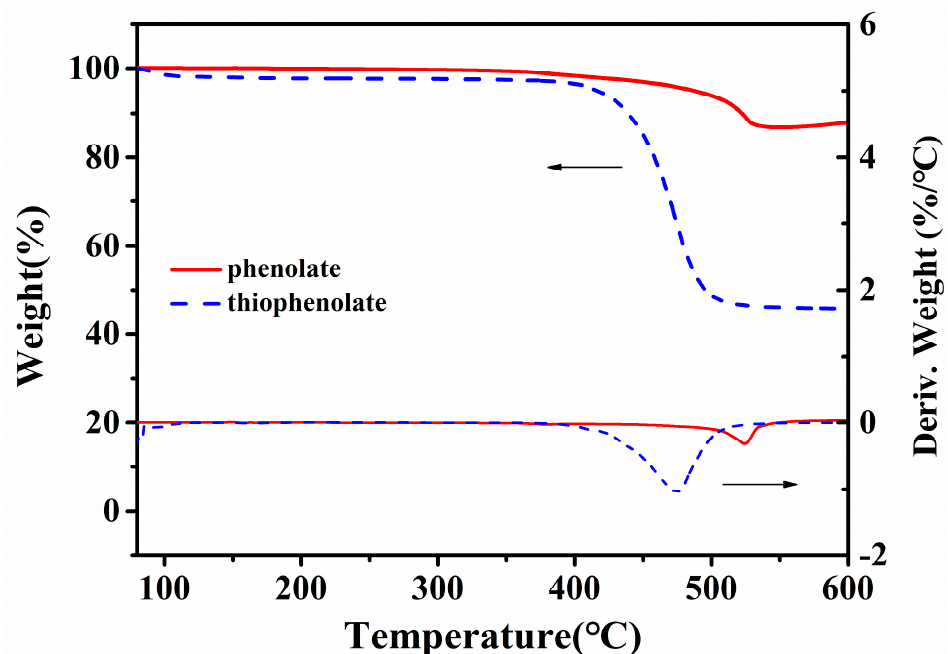
Figure 1. Thermogravimetric analyses of sodium phenolate and thiophenolate under N 2 .